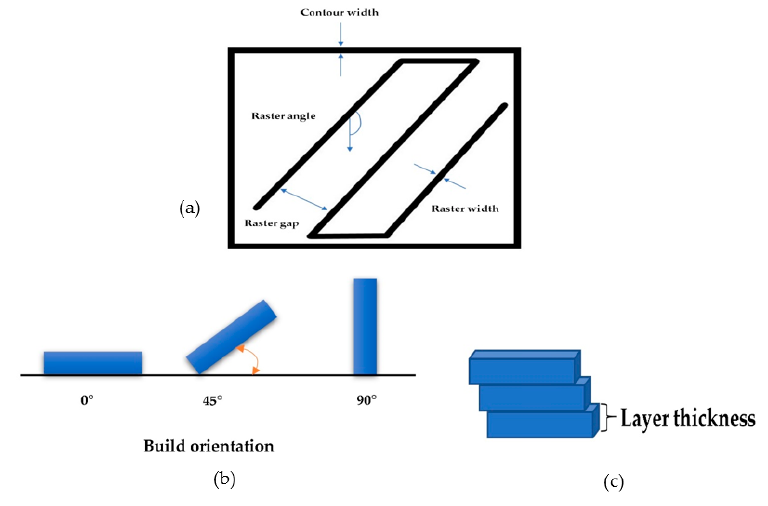
Figure 2. ( a ) FDM path parameters, ( b ) build orientations, and ( c ) layer thickness.